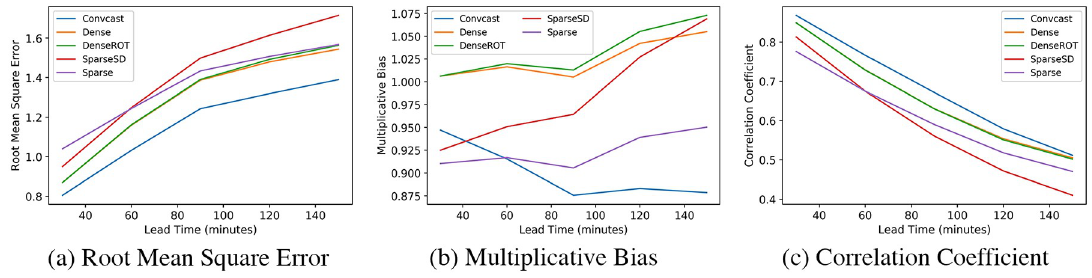
Fig 6. Variation of accuracy scores based on continuous variables with time.